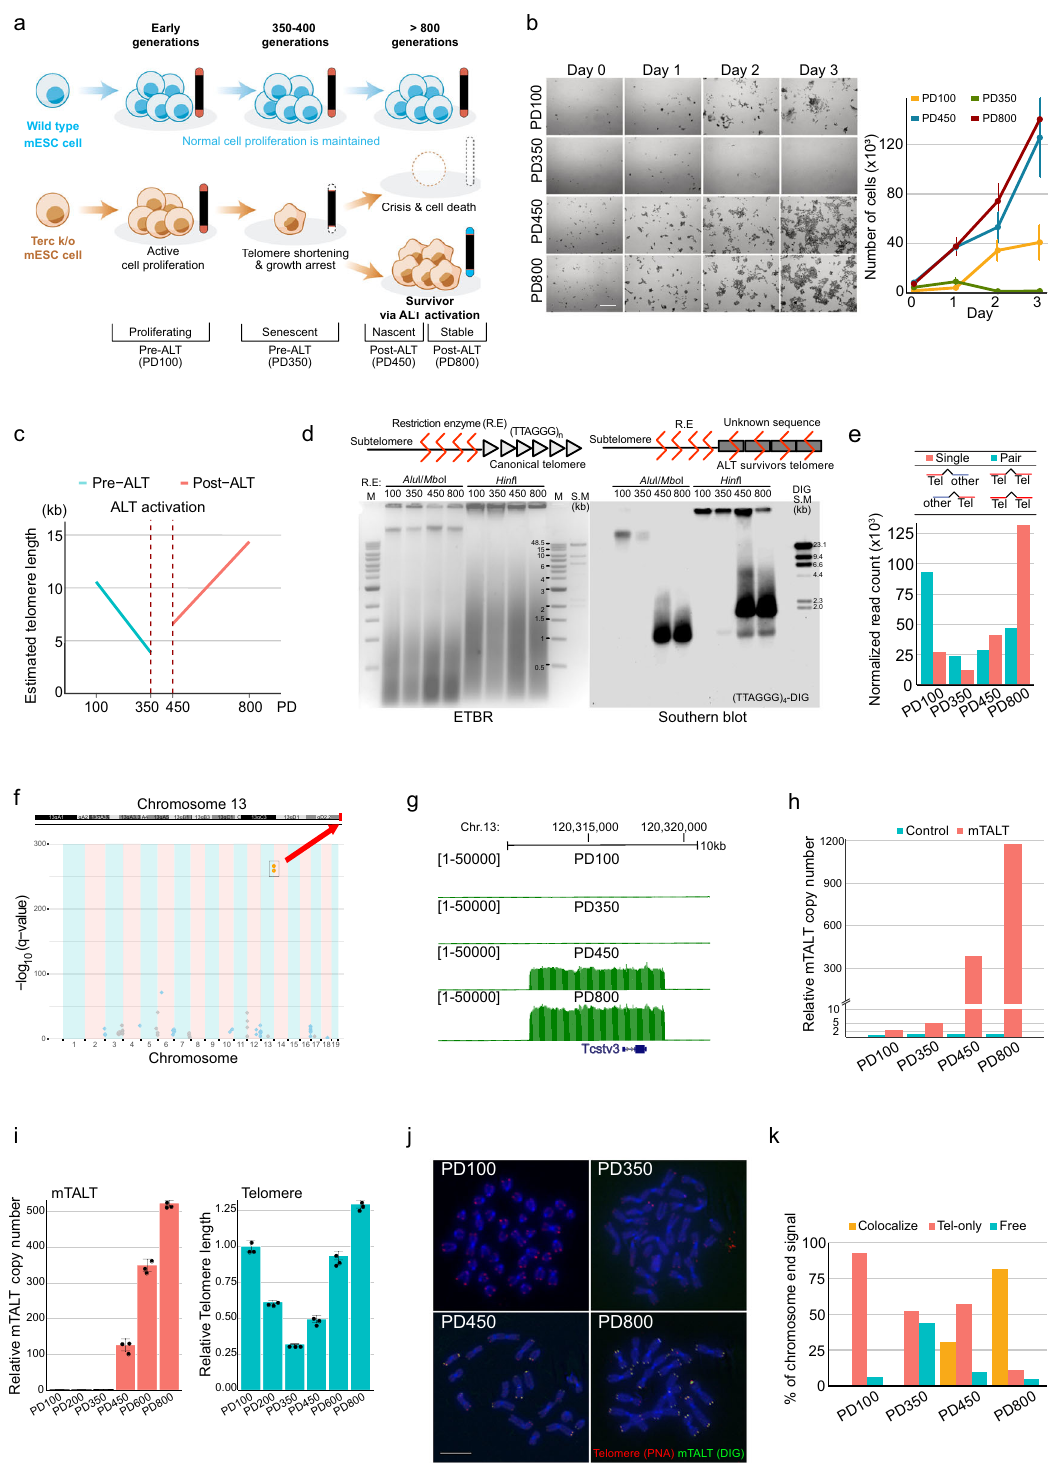
named the region m ouse t emplate for ALT (mTALT). The copy number of mTALT increased as cells progressed from the pre- ALT state to ALT activation and stabilisation (Fig. 1h, i, Supplementary Fig. 1f, g). Using a PCR assay, mTALTs were also detected at locations other than the original site at chromosome 13 (Supplementary Fig. 1h). While ~30% of telomeres of the PD450 cells colocalised with mTALT, telomeres of PD800 cells showed ~80% of co-localisation,